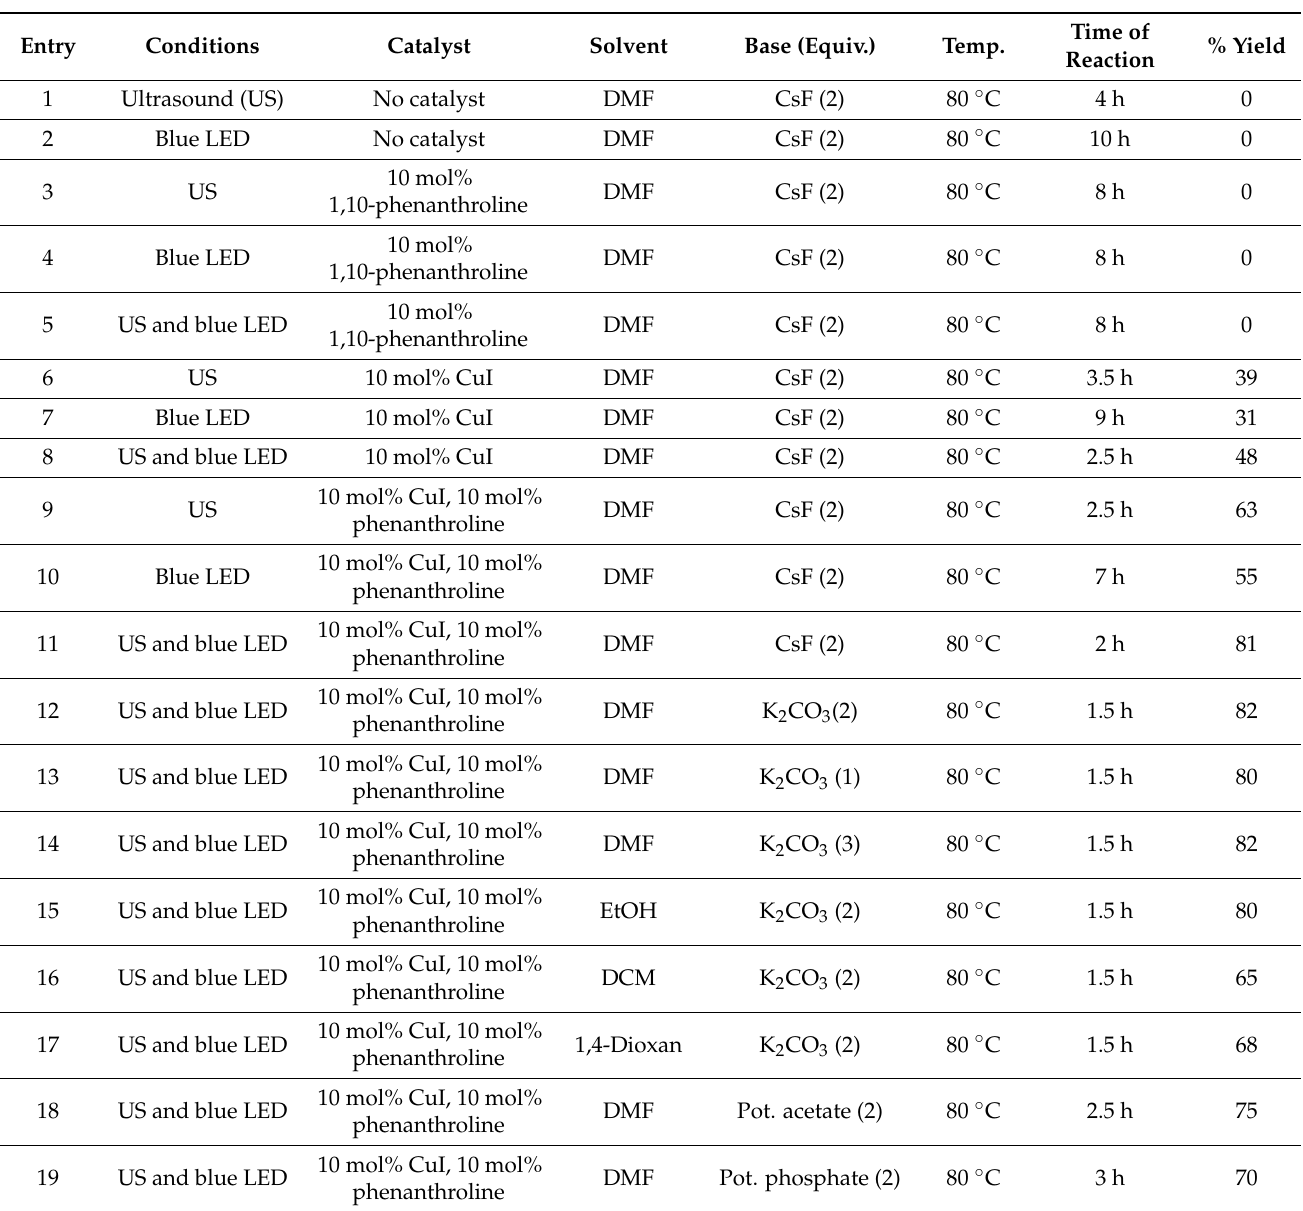
Table 1. Synthesis of compound 3a using different catalysts under ultrasonic irradiation, blue LED light, and sonophotoreactor